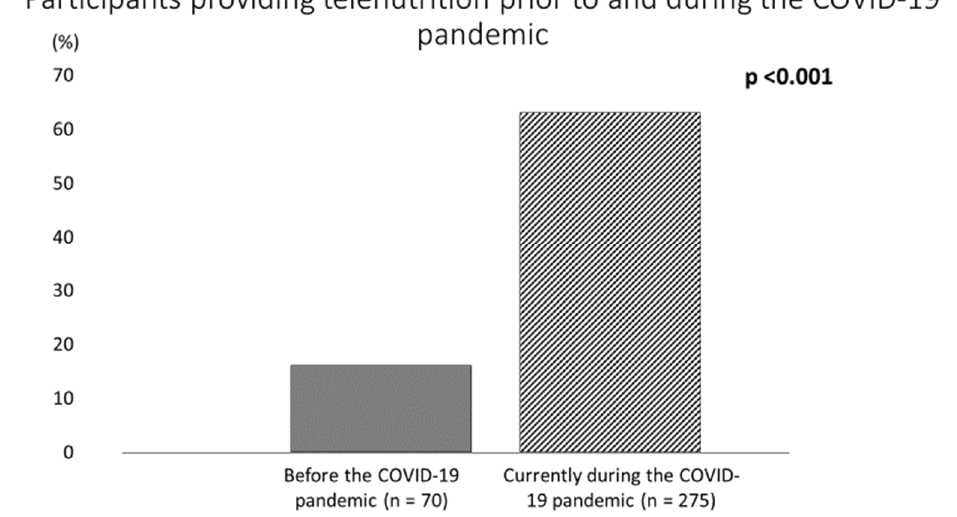
Figure 4. Participants providing telehealth prior to and during the COVID-19 pandemic. Those who used telemedicine prior to the COVID-19 pandemic had a median of 4.7 ± 5 years of professional experience (Table 2). During the COVID-19 pandemic, the greatest proportion of RDNs (46.9%) reported exclusively using audio–visual modalities, while 32.4% reported using both audio–visual and telephone (audio-only) modalities to provide nutrition care via telemedicine (Table 2). Among the audio–visual options, the greatest proportion of RDNs used Google Meet (23.6%) to provide nutrition care via telehealth (78.5%) rather than groups (4.4%). Furthermore, RDNs indicated spending a mean of 47 ± 34 min per visit with patients per telehealth service (data not shown). The majority of and food consumption (84.7%), nutrition history (82.5%), and patients’ self-reported body measurements (62.9%) (Table 2). During the COVID-19 pandemic, 84% of the